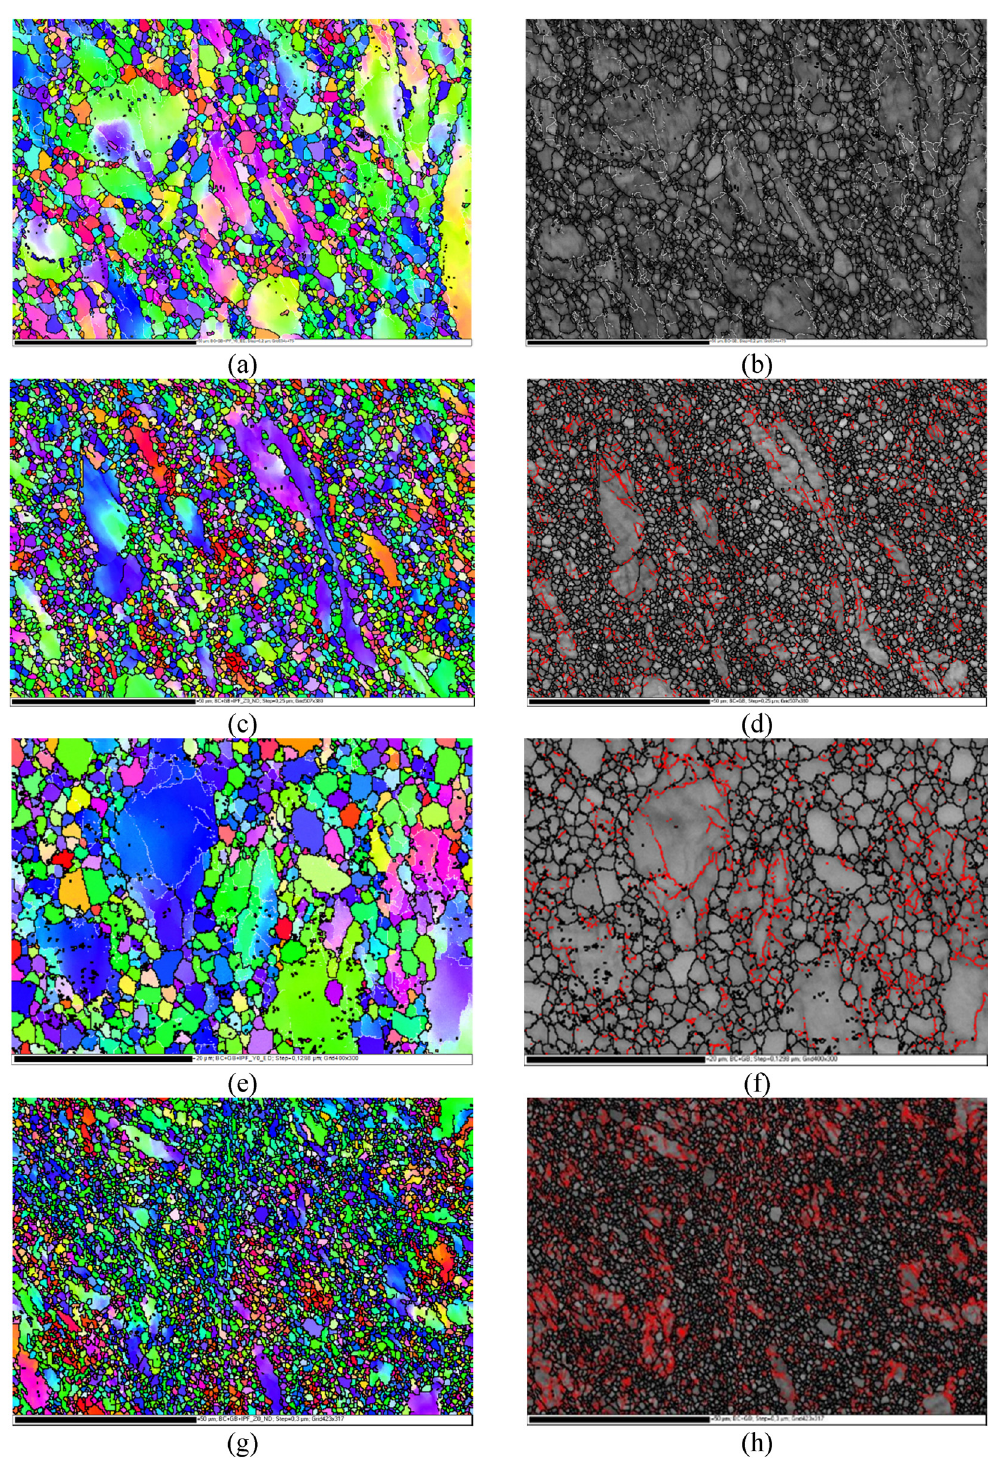
Figure 4: IPF coloring maps and their corresponding band BC maps with high - angle boundaries > 15° in black lines and low - angle boundaries 3 – 15° in white lines ( b ) and ( d, e, h ) red lines, superimposed for the Mg billets processed through ( a and b ) 1 - pass or ( c and d ) 2 - passes of route A, ( e and f ) 2 - passes of route Bc, and ( g and h ) 2 - passes of route C using the ECAP die with channel angle of